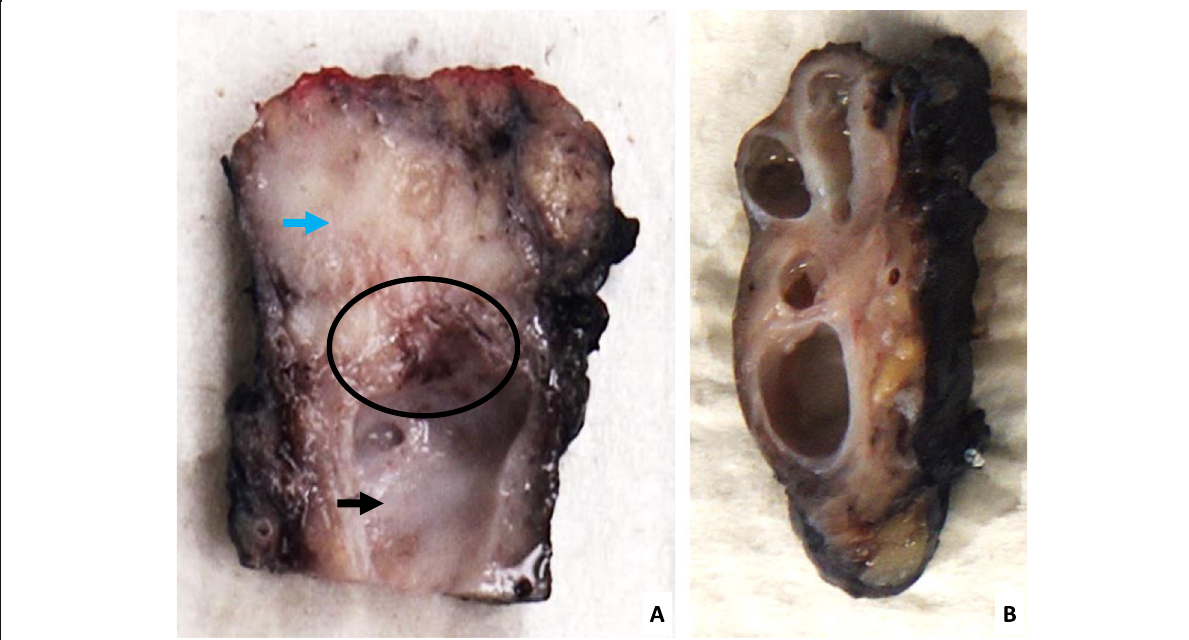
Fig. 2 Macroscopic examination. A Slice of the pancreatectomy, with the section margin at the top of the image, and the body towards the bottom of the image. Blue arrow: a 12 mm indurated white lesion, close to the surgical margin. Black arrow: a 15 mm cystic lesion extending into the rest of the pancreatic body, right next to the white lesion. Circle: A contact between this whitish lesion and the cystic lesion is presumed. B Prolongation of cystic lesions in the rest of the pancreatic